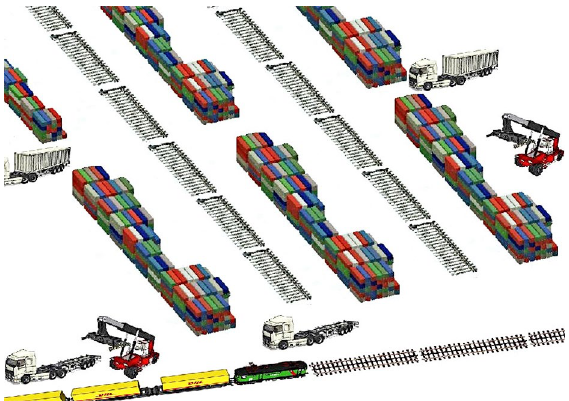
Fig. 4. Combined type of handling space